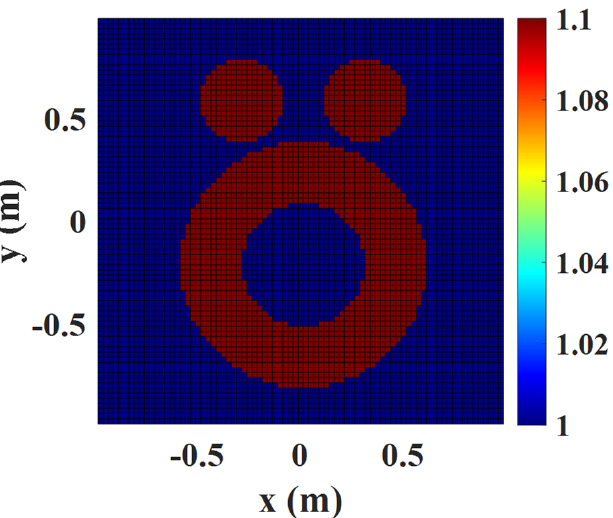
Figure 2. Ground truth of the “Austria” profile. The color bar represents the value of the relative permittivity.